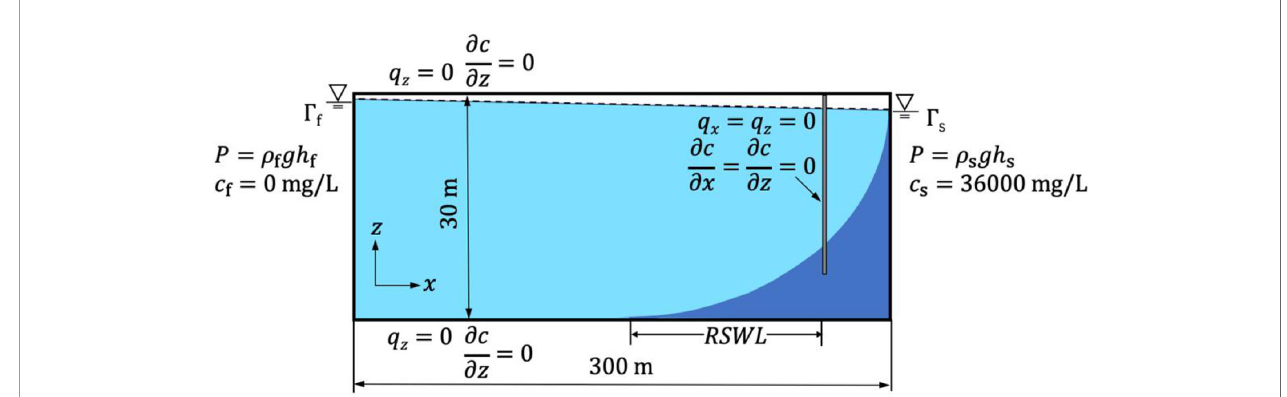
FIGURE 5 | Model setup for the fi eld-scale numerical simulation in an uncon fi